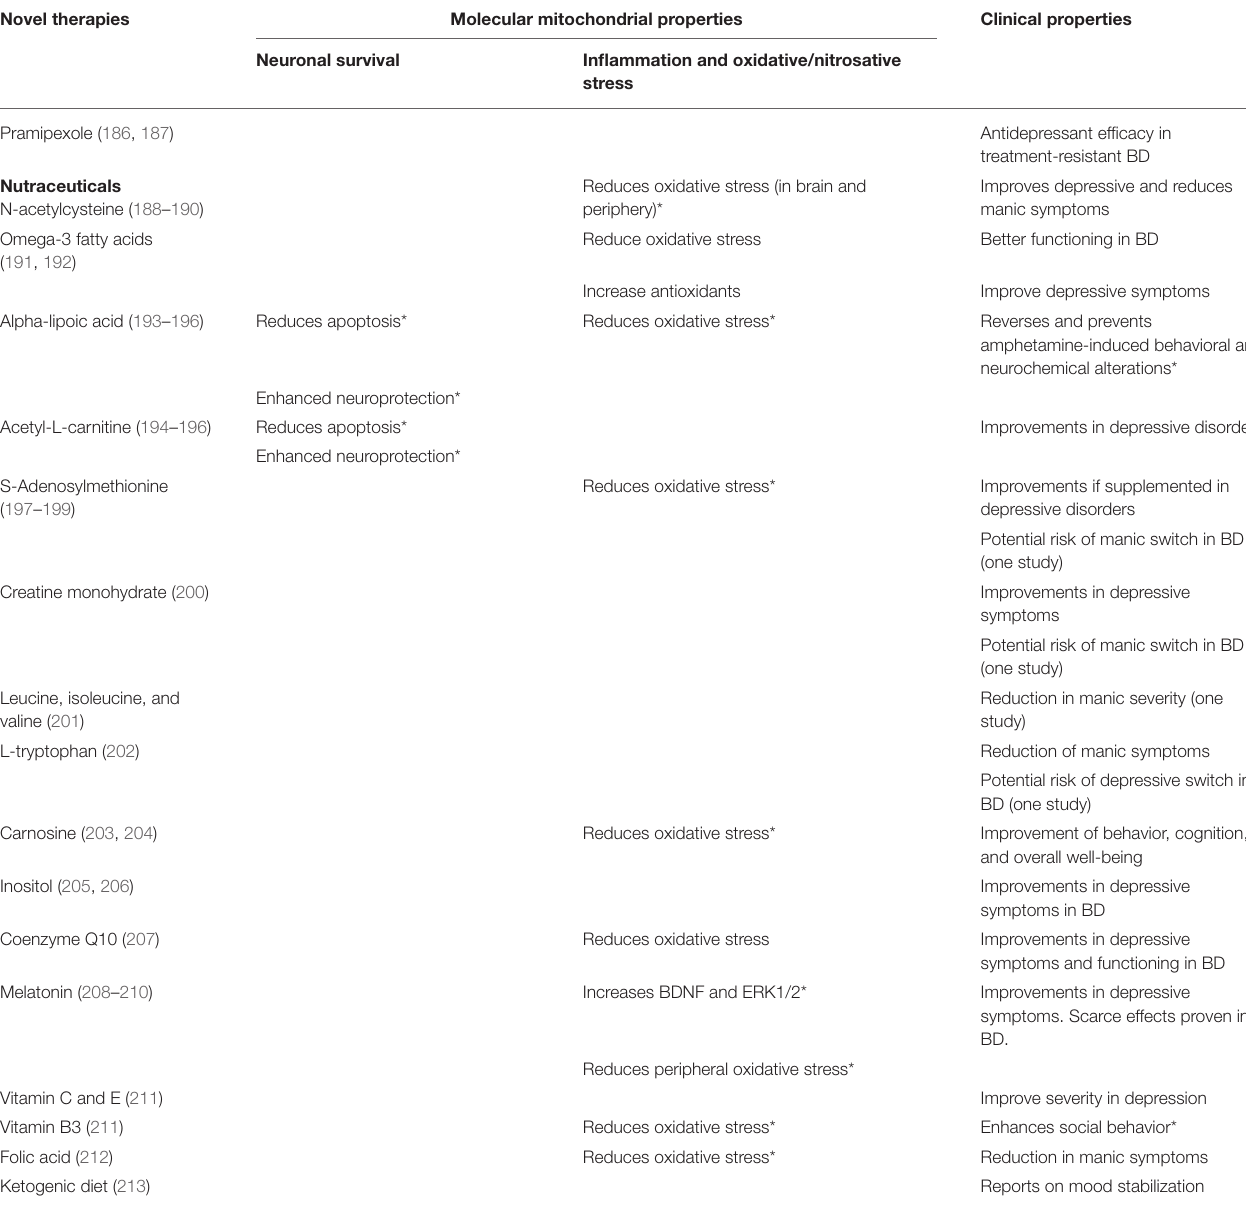
TABLE 2 | Effects of novel therapies on mitochondrial